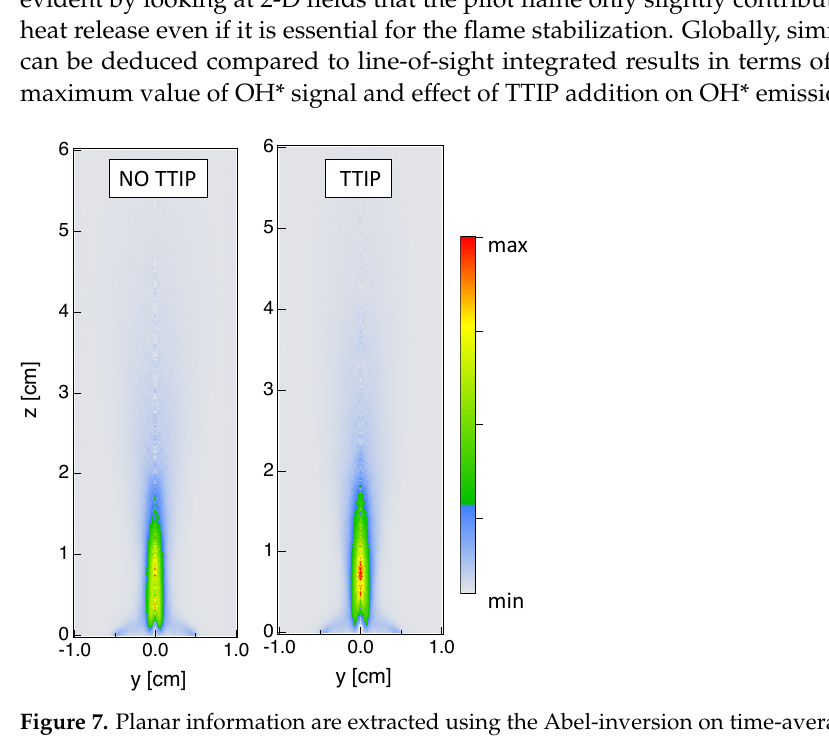
Figure 7. Planar information are extracted using the Abel-inversion on time-averaged results from OH* chemiluminescence for the reactive cases ( left ) without and ( right ) with injection of